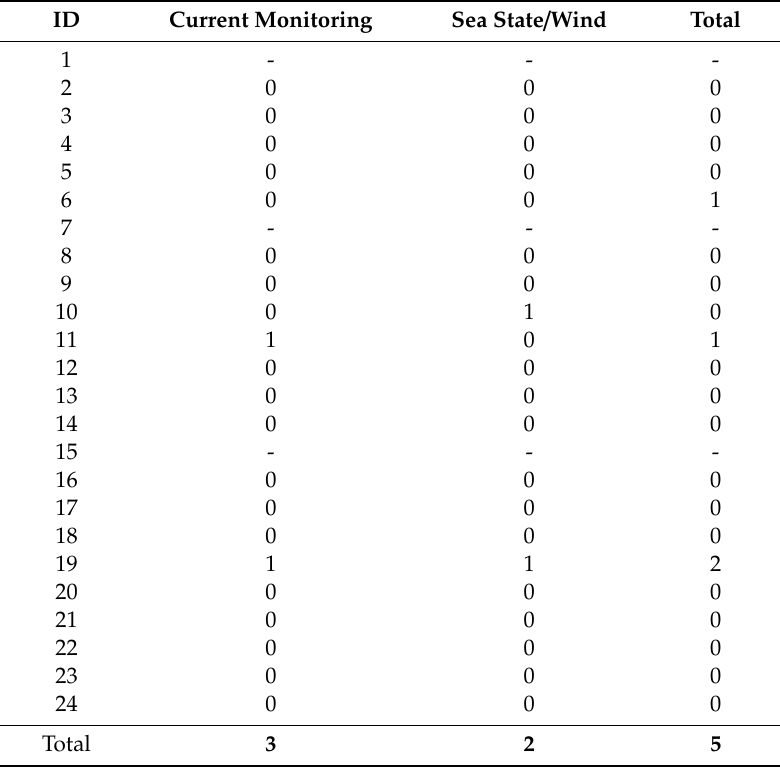
Table A5. Others irrelevant descriptors